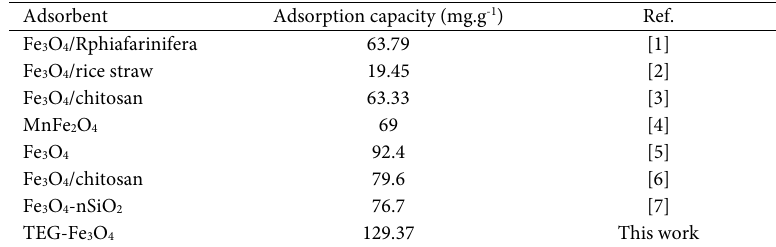
Fig. 14. Schematic adsorption mechanism of Pb (II) ions by TEG-Fe Table 5. Comparison of the removal capacity by magnetic nano-adsorbents for Adsorbent Adsorption capacity (mg.g -1 ) Ref.